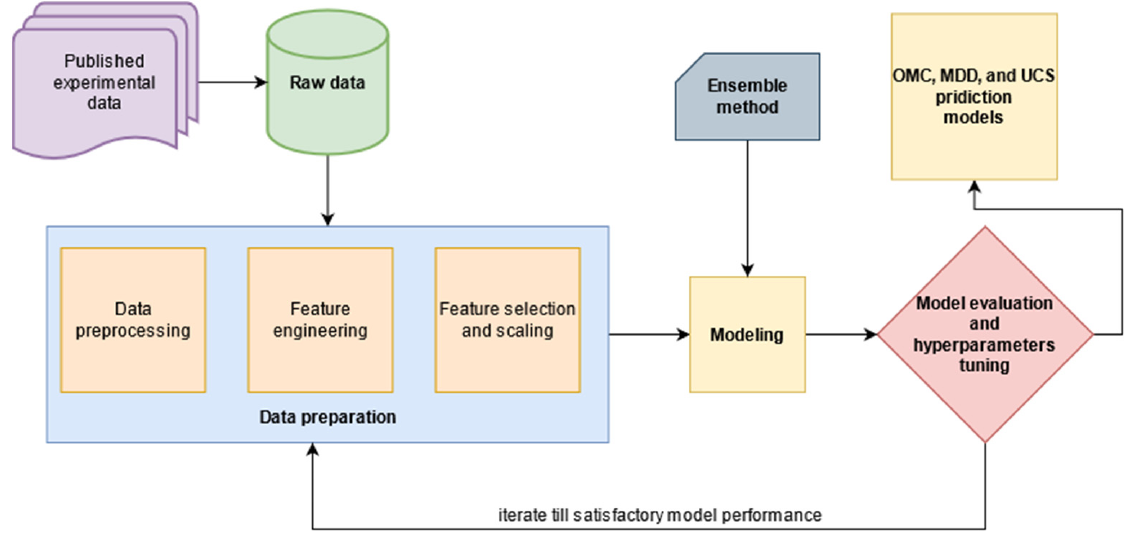
Figure 1. The development process of OMC, MDD, and UCS prediction models.